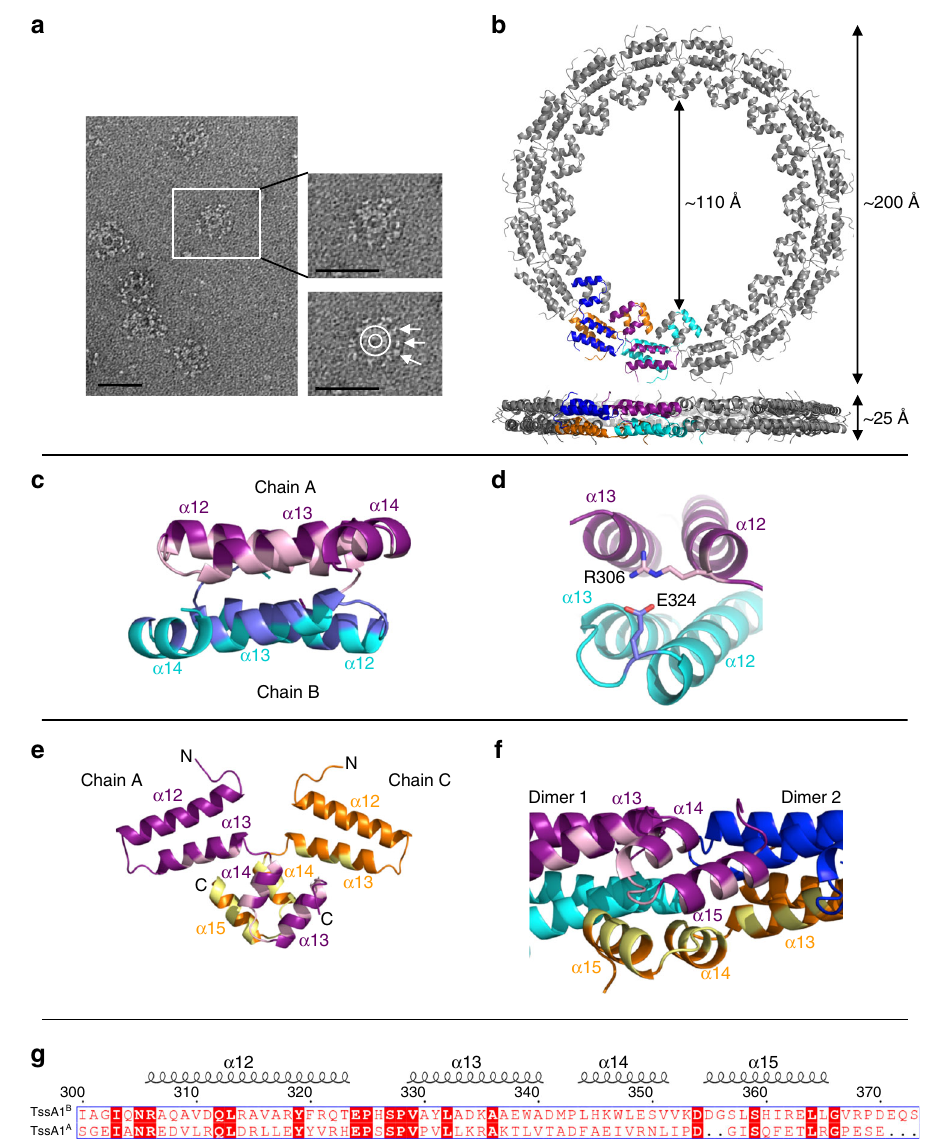
Fig. 5 Structure of the Bc TssA1 B CTD ring. a Negative stain EM of TssA1 B particles. The magni fi ed view indicates the location of the Nt1 domains (arrows) presented around the CTD oligomeric ring (circle). Scale bar corresponds to 50 nm. b Bc TssA1 B CTD monomers assemble to form a double-layered ring containing 32 subunits exhibiting D 16 symmetry (PDB: 6HS6 [https://www.ebi.ac.uk/pdbe/entry/pdb/6hs6]). The views shown correspond to a top view down the 16-fold axis and a side view perpendicular to the 16-fold axis, with the dimensions of the ring shown. c , d Dimerisation of Bc TssA1 B CTD monomers. c Side view from inside the Bc TssA1 B CTD ring showing interaction of residues from helices α 12, α 13 and α 14 within a dimer (chain A, purple; chain B, cyan). Interacting surfaces are highlighted (chain A, light pink; chain B, blue). d Formation of the salt bridge between R306 and E324 that caps both ends of the dimer interface. e , f Interactions between dimers to form the Bc TssA1 B CTD ring. e Expanded view of the two chains shown in purple and orange in ( b ), to show interactions leading to ring assembly. f Side view from inside the Bc TssA1 B CTD ring showing the interlocking interaction between helices α 13, α 14 and α 15 from two dimers which are critical to ring formation around the 16-fold axis: dimer 1, purple/cyan; dimer 2, blue/orange. The interfacing regions of the purple and orange monomers are shown in light pink and yellow, respectively. g Structure-based sequence alignment of the Pa TssA1 A and Bc TssA1 B CTD domains. The secondary structure of TssA1 B CTD is highlighted above the sequence